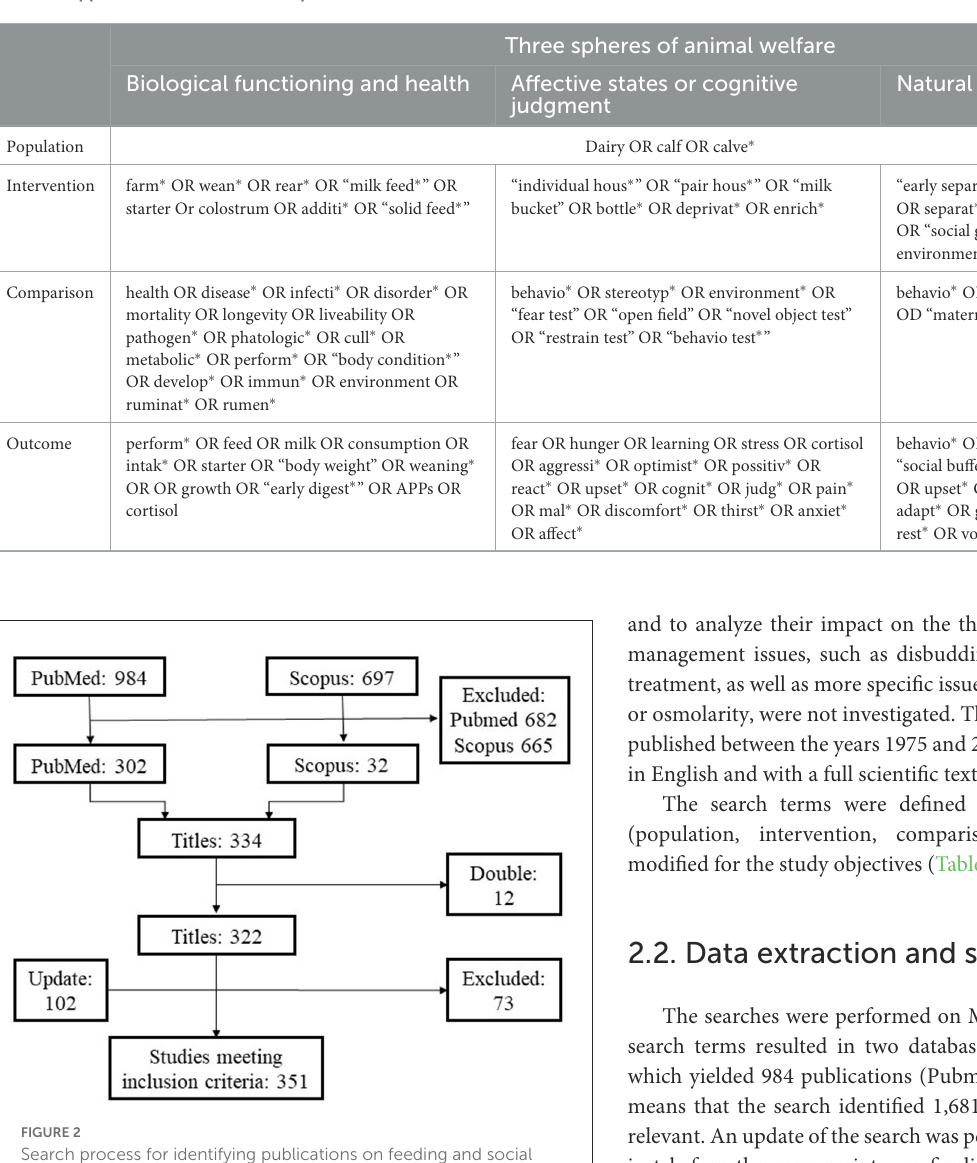
TABLE 1 Approach and structured steps used to search the literature for this review.